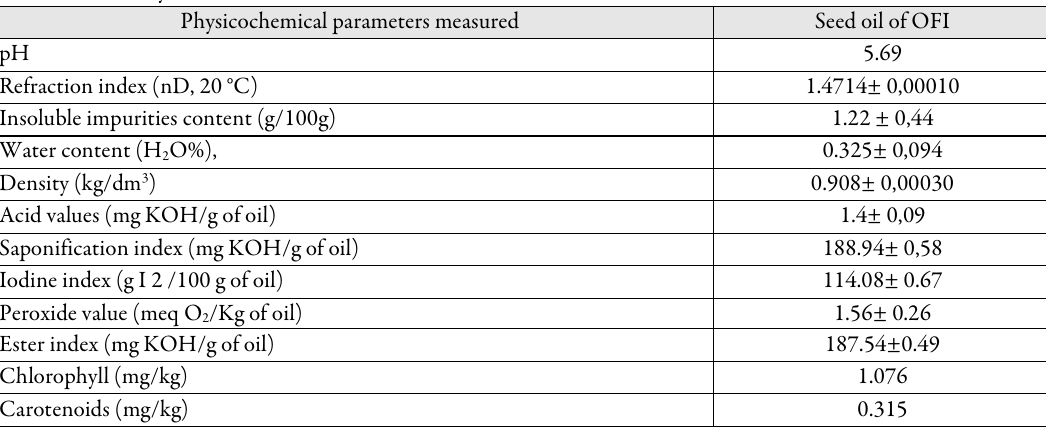
Table 2. Physicochemical characteristics of the oil